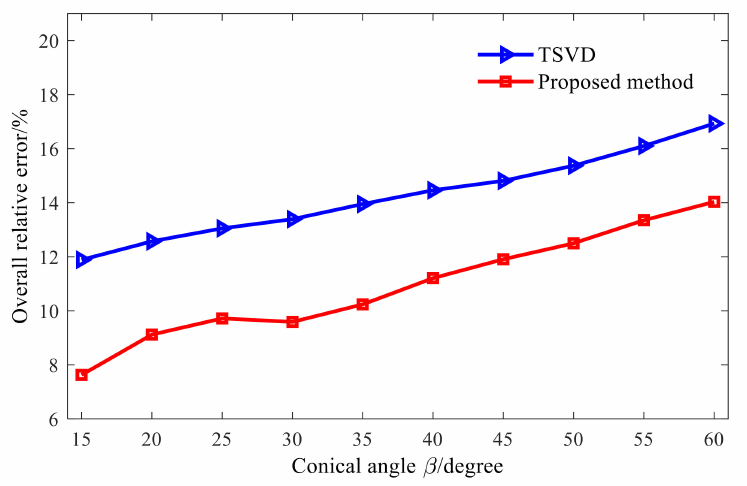
Figure 19. Reconstruction by the two methods under different cone